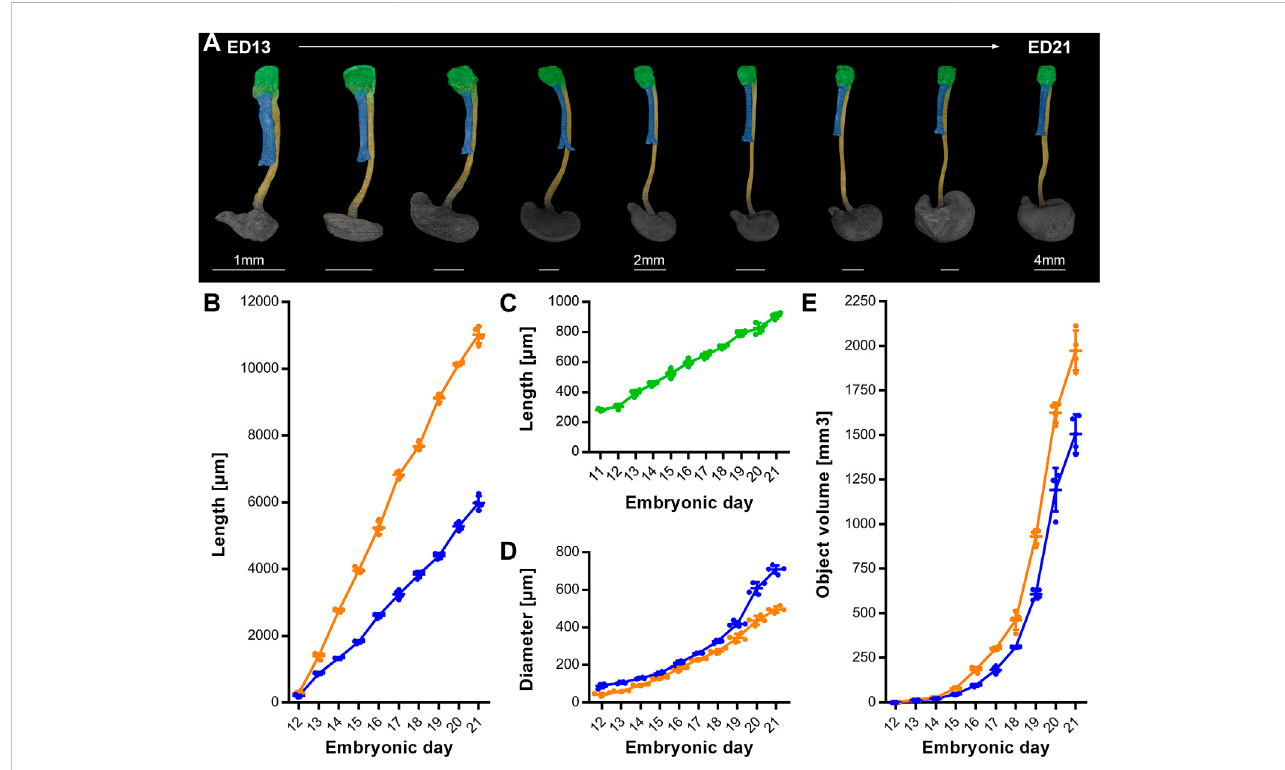
FIGURE 5 Growth dynamics of the intermediate compartment/ larynx, trachea and esophagusfrom ED11 to ED21. (A) Representative reconstructions showing the growth ofthelarynx,trachea,esophagusand stomachovertime; p < 0.0001.Lightgreen:Larynx -hypopharynx, blue:Trachea, yellow: Esophagus,dark gray: Stomach, (B) Measured lengths of trachea (blue line) and esophagus (orange line) over time; p < 0.0001. (C) Measured lengths of the larynx (light green line) over time; p < 0.0001. (D) Measured diameter of trachea (blue line) and esophagus (orange line) over time; p < 0.0001. (E) Measured object volumes of trachea (blue line) and esophagus (orange line) over time; p <